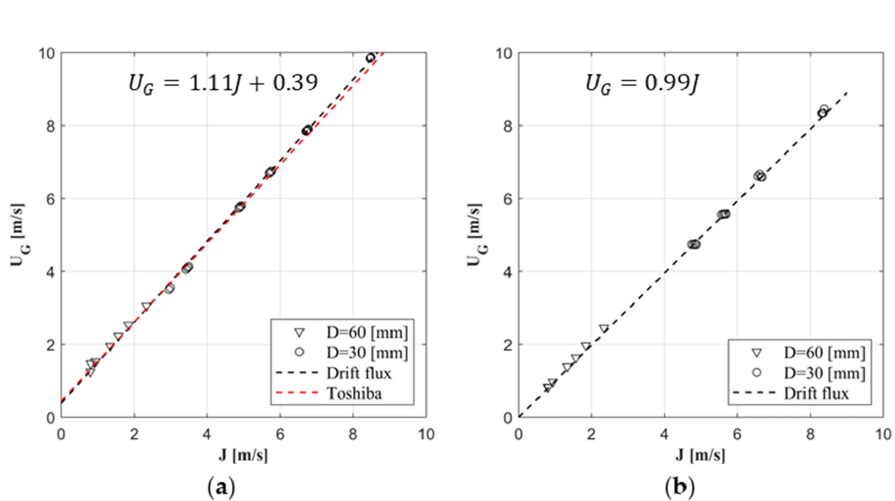
Figure 6. ( a ) AW flow results compared with the Drift–Flux and Toshiba models (Toshiba MRD = 2.63% and MARD = − 1.21%) and ( b ) AWF flow results compared with Drift–Flux model.